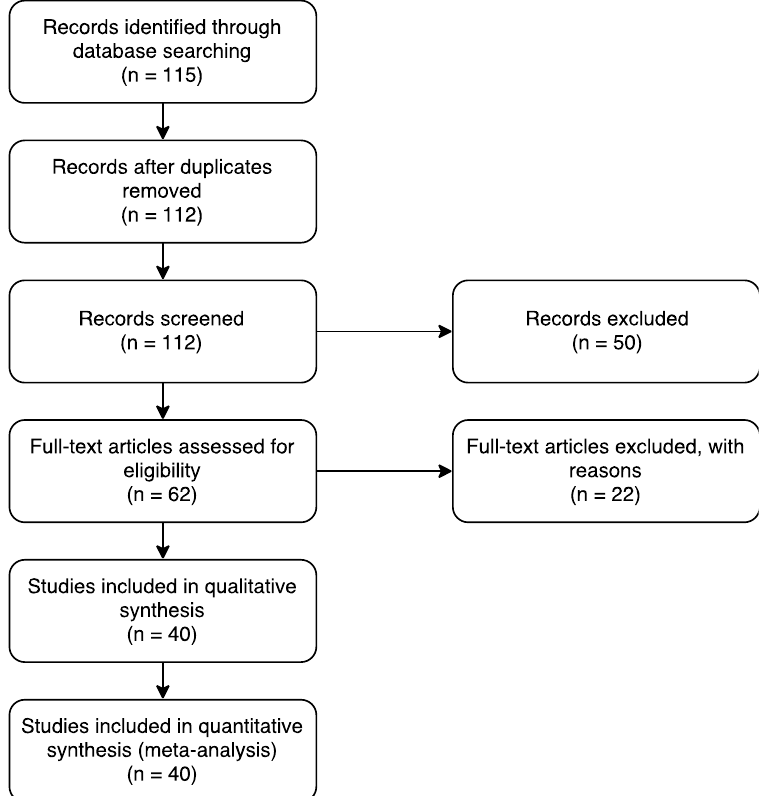
Figure 1. Flow diagram of identification and inclusion of papers.